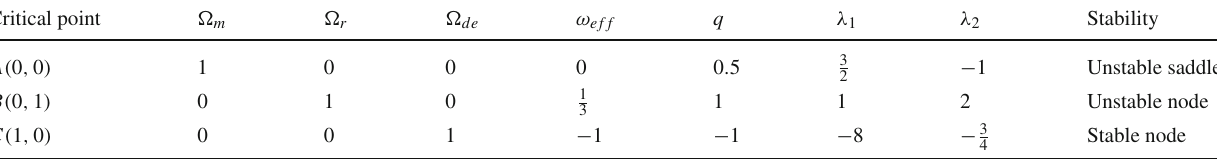
Fig. 6 Phase-space trajectories on the x − y plane for model-I (left panel) and model-II (right panel) Table 3 Eigen values and critical points for the dynamical system corresponding to